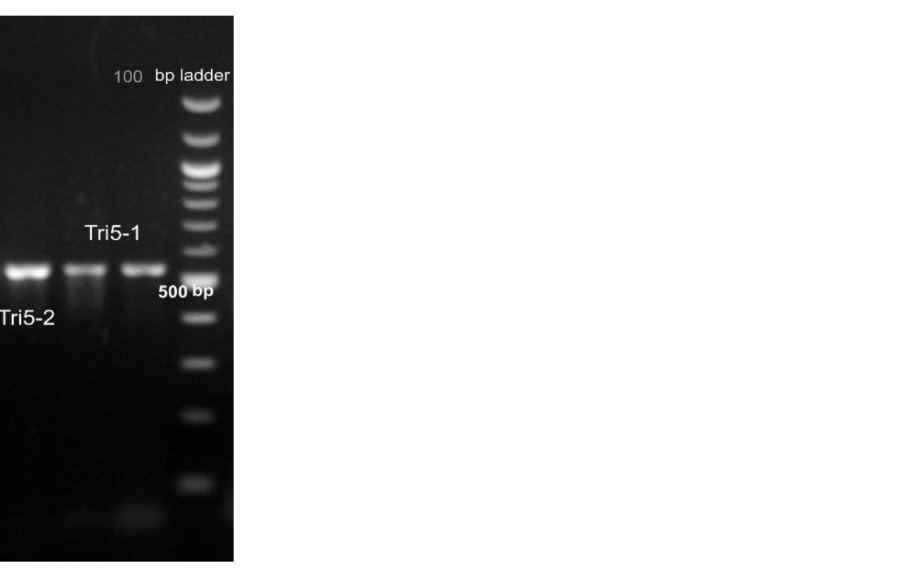
Figure 3. Qualitative Tri-5 -specific PCR assay giving Tri-5 DNA bands with three intensity